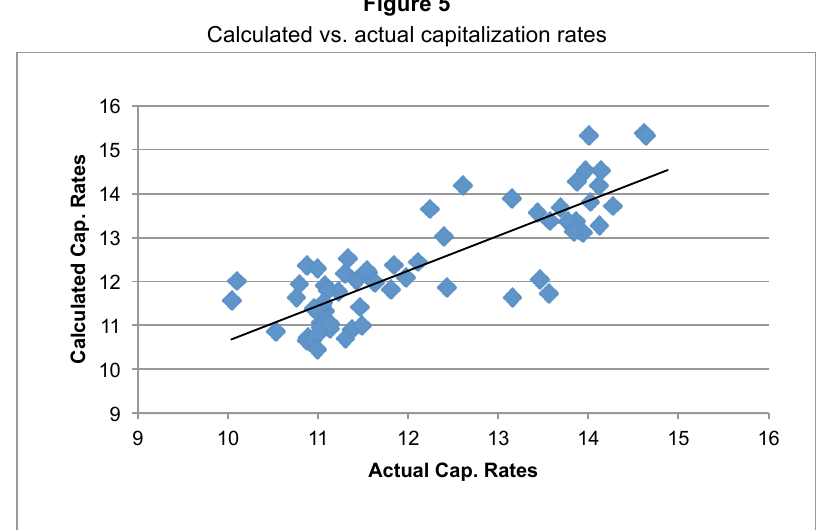
Calculated vs. actual capitalization